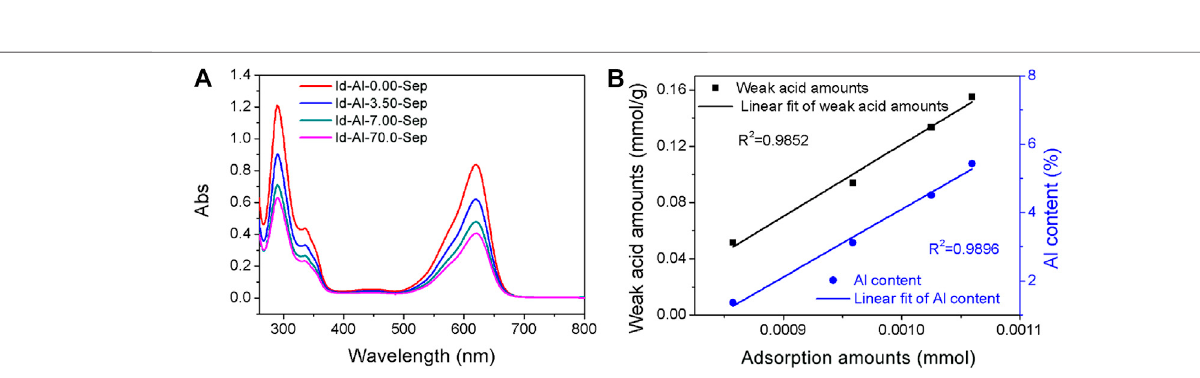
FIGURE 7 | (A) XRD pattern and (B) FTIR spectra of Sep, Id, and composite pigment prepared by Id and Al-Sep.